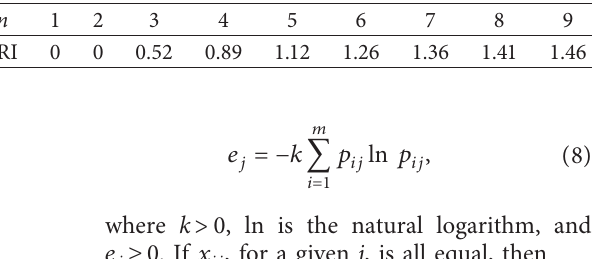
Table 1: Average random consistency